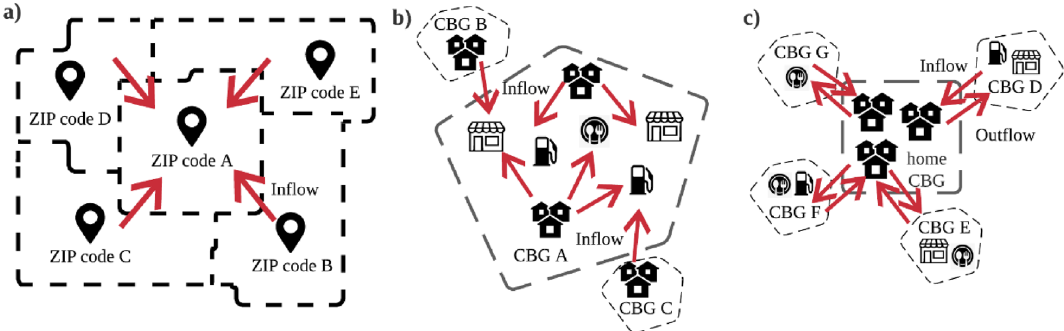
Figure 1. Mobility patterns and population activity yield exposure risk indicators. Exposure risk indicators are measured through ( a ) inflow measures from ZIP codes B, C, D, E to ZIP code A, ( b ) percent change of visits to POIs in CBG A with from CBG B and CBG C, ( c ) previous transmission at POIs in CBG D, E, F, G to home